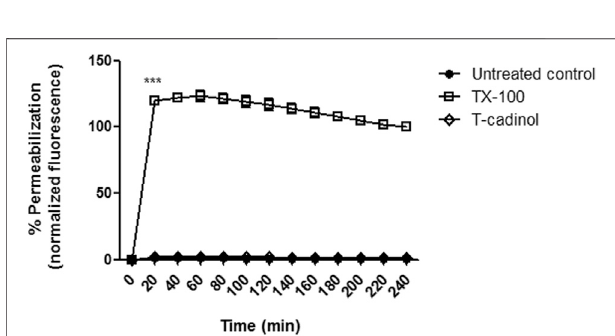
FIGURE 3 | – Evaluation of plasma membrane permeabilization in T. cruzi trypomastigotes treated with compound 1 ( T-cadinol − 18.2 μ M) for 4 h. Sytox ® Green dye fl uorescence was monitored spectro fl uorimetrically (excitation 485 nm and emission 535 nm) every 20 min. Untreated trypomastigotes and those treated with 0.5% TX-100 were used as negative and positive controls, respectively. Fluorescence is reported as the percentage relative to time 0 min (0%) and TX-100 240 min (100%). *** p <